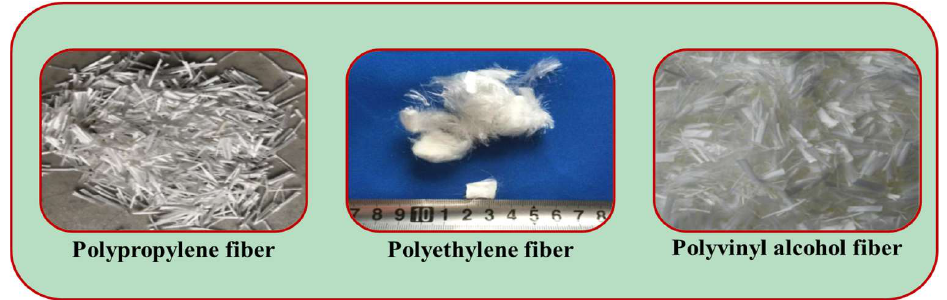
Figure 8. Typical types of synthetic fiber.